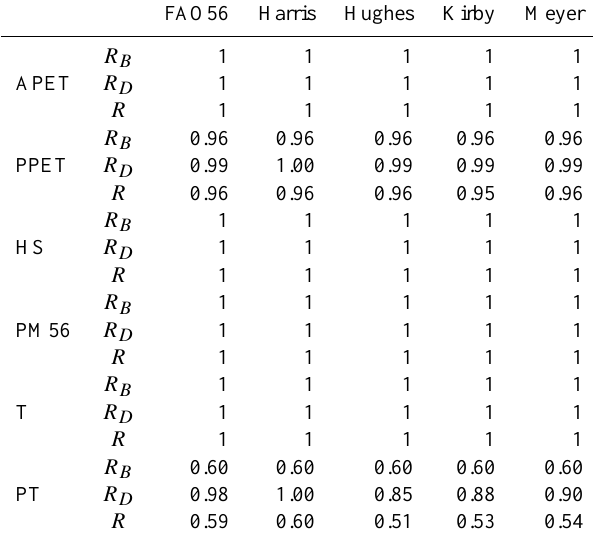
Table 4. Performance ( R B ) and convergence ( R D ) and reliability ( R) coefficient of the ensemble members. Harris